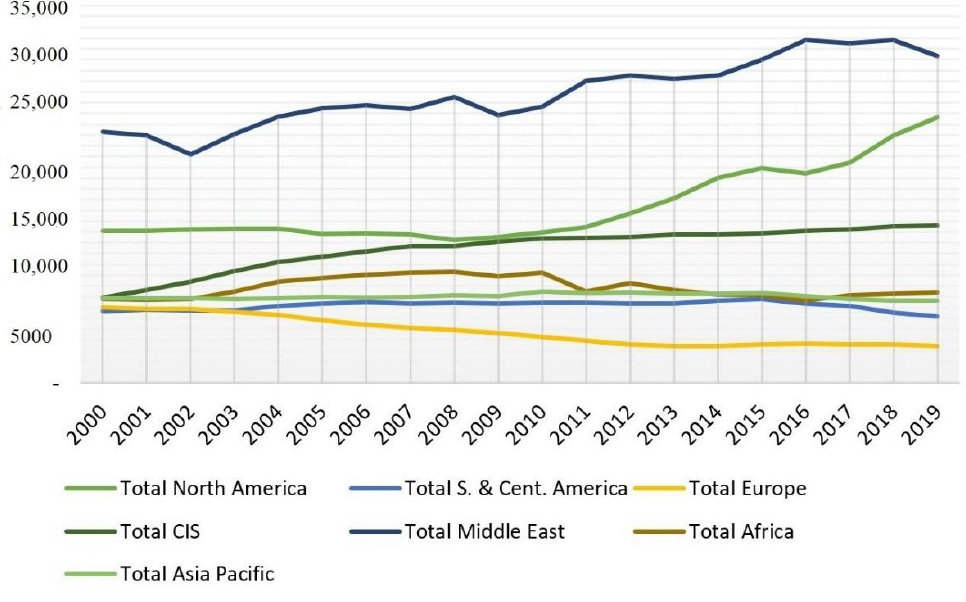
Figure 4. Global oil production (thousand barrels per day). Source: developed by the authors based on statistical data [28].